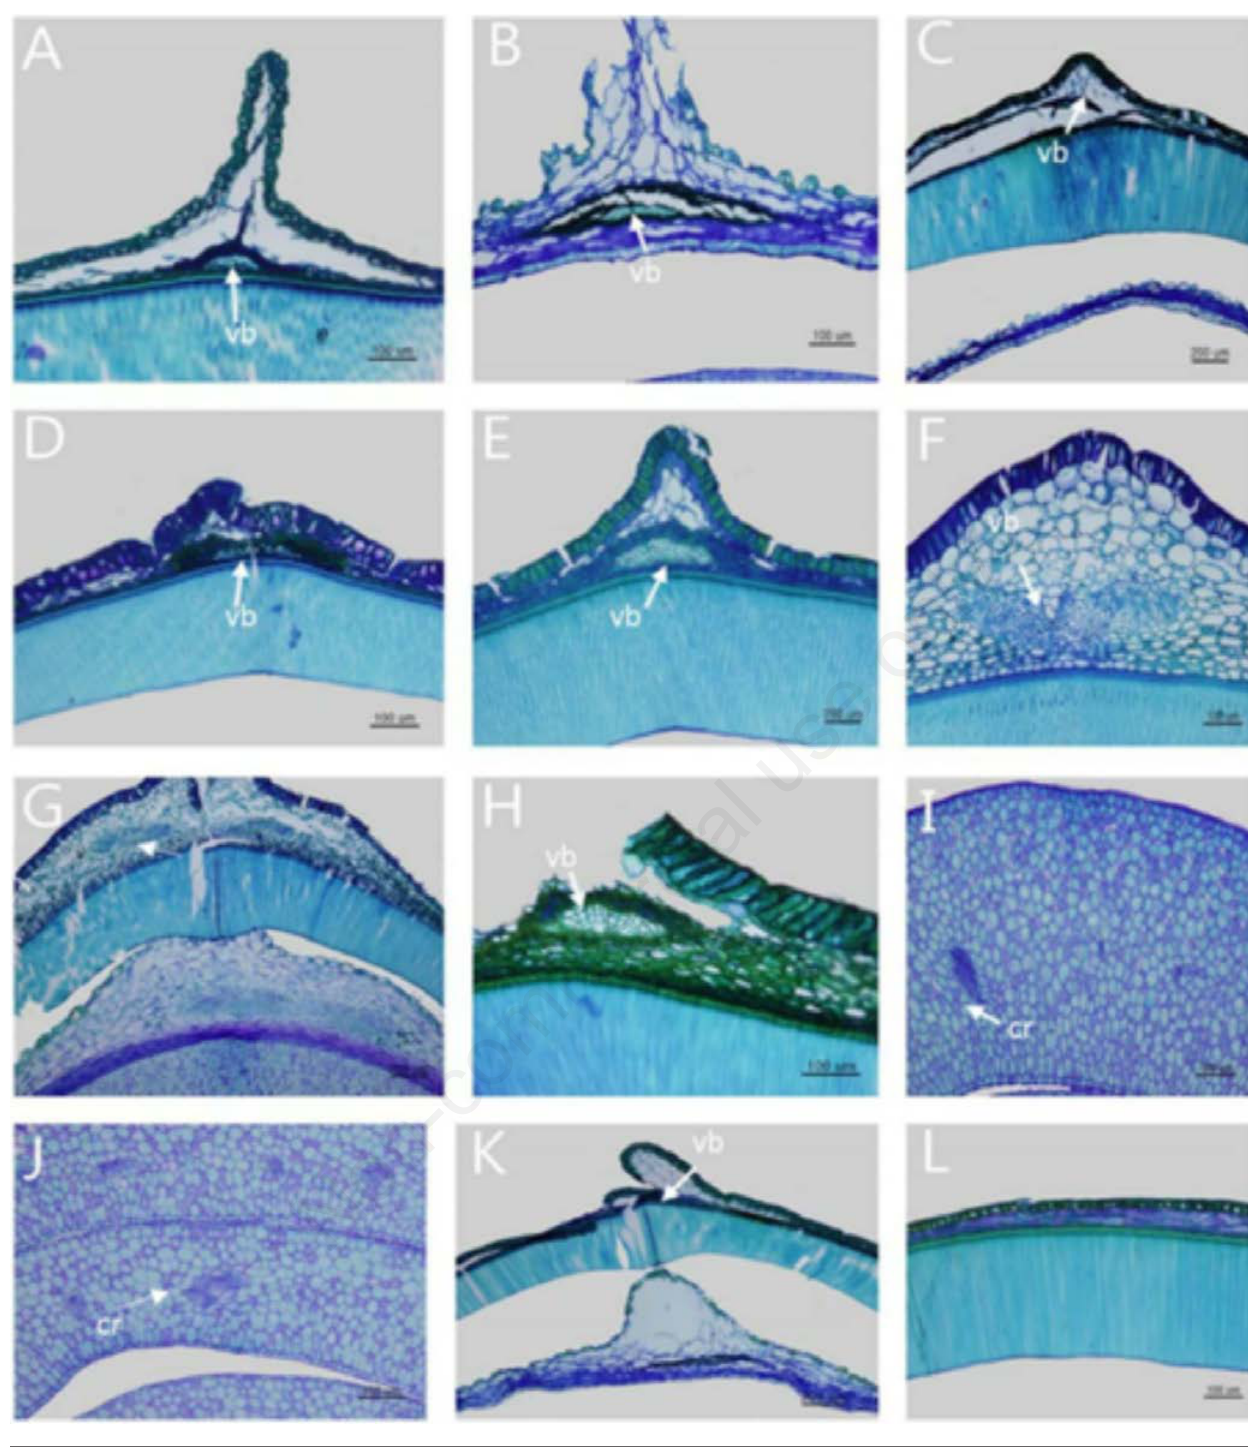
Figure 6. Seed anatomy of Calycanthaceae. A, Sinocalycanthus chinensis ; B and K, Calycanthus occidentali s; C, Chimonanthus praecox ; D and L, Chimonanthus nitens ; E, Chimonanthus fragrans ; F and G, Chimonanthus salicifolius ; H and I, Chimonanthus luteu s; J, Chimonanthus yunnanensis . Abbreviation: Vb, vascular bundle; cr,